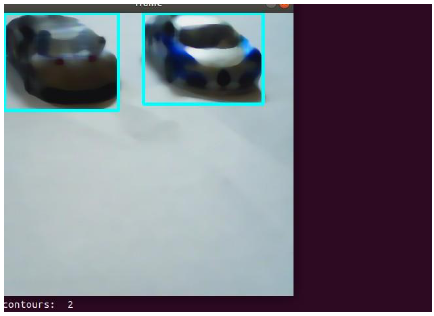
Figure 7. Car Detection by Contours The above image is the contours detected by our system.